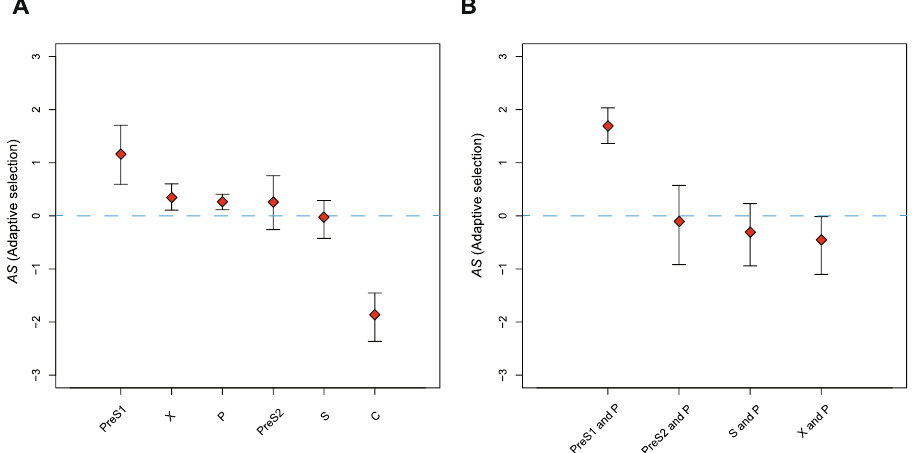
Figure 4. Adaptive evolution of protein-coding genes in HBV. Plots of AS statistics for protein-coding genes in HBV. ( A ) Independent gene evolutions were estimated based on NNS + INS or INS ( PreS1/PreS2/S contains no NNS variants) variants, and ( B ) co-evolutions of overlapped genes were estimated with DNS variants, using all observed mutations from eight genotypes. Genes or regions with few observations of fixed or polymorphic mutations ( < 10 mutations) are not showed (Table 2). Error bars indicate 90% confidence intervals and blue dashed line denotes neutral index similar as in Fig. 3.